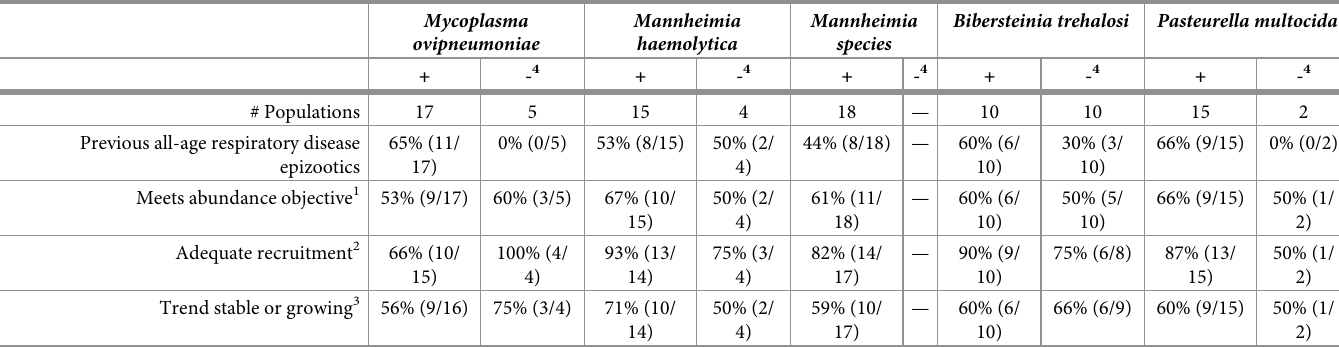
Table 2. Herd attributes and pathogen detection status for 22 bighorn sheep